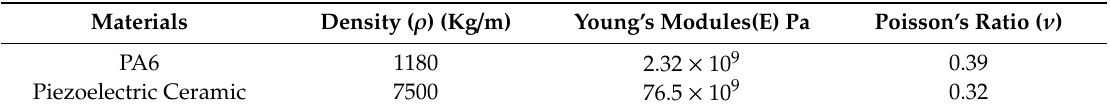
Table 1. The mechanical parameters of the two